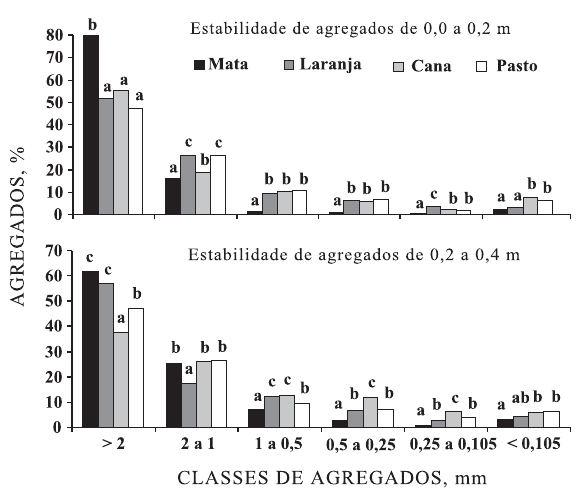
Figura 3. Distribuição e estabilidade de agregados em água do Latossolo sob diferentes usos. Médias seguidas da mesma letra em cada classe não diferem estatisticamente entre si pelo teste de Tukey a 5